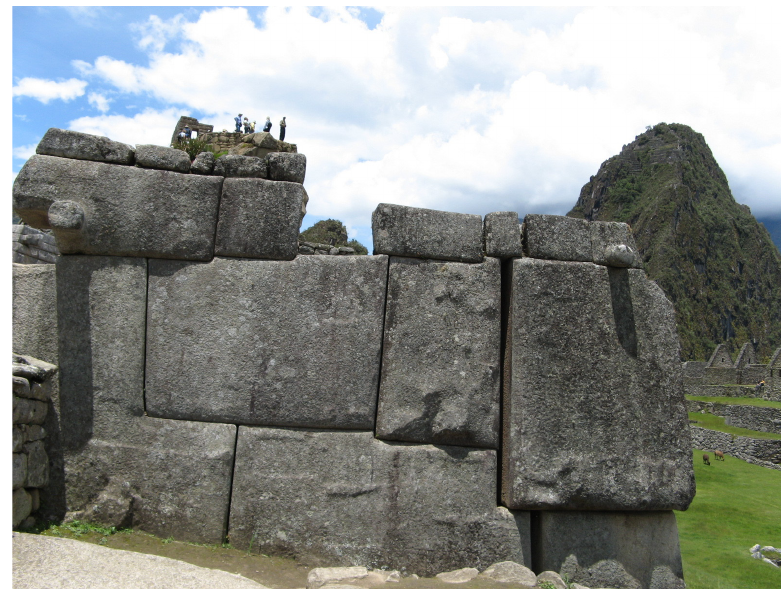
Figure 2. Cyclopean wall in Machu Picchu (Peru).